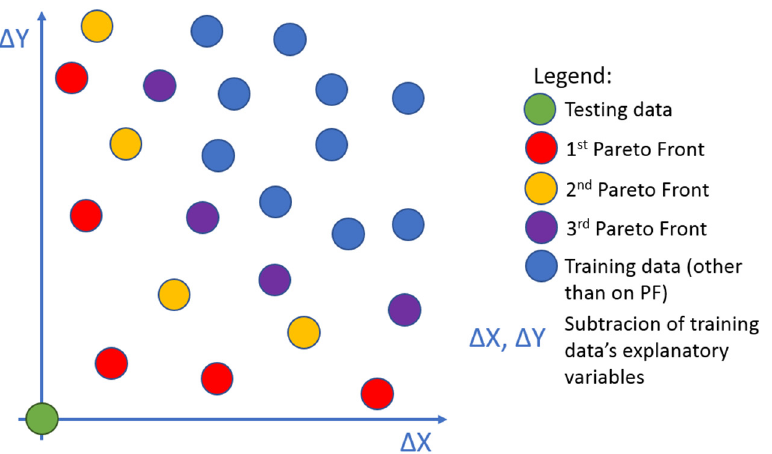
Figure 4. The example of testing data belonging to the first, the second, and the third Pareto front in one quadrant.